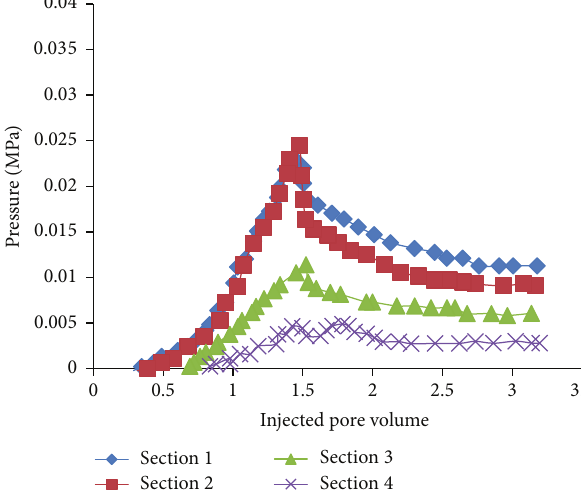
Figure 9: The plot of the injection pressure (diameter: 0.02 mm, concentration: